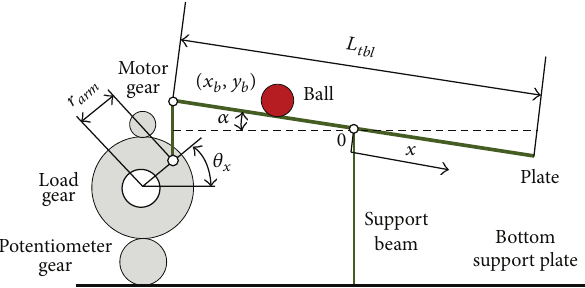
Figure 2: The ball and plate